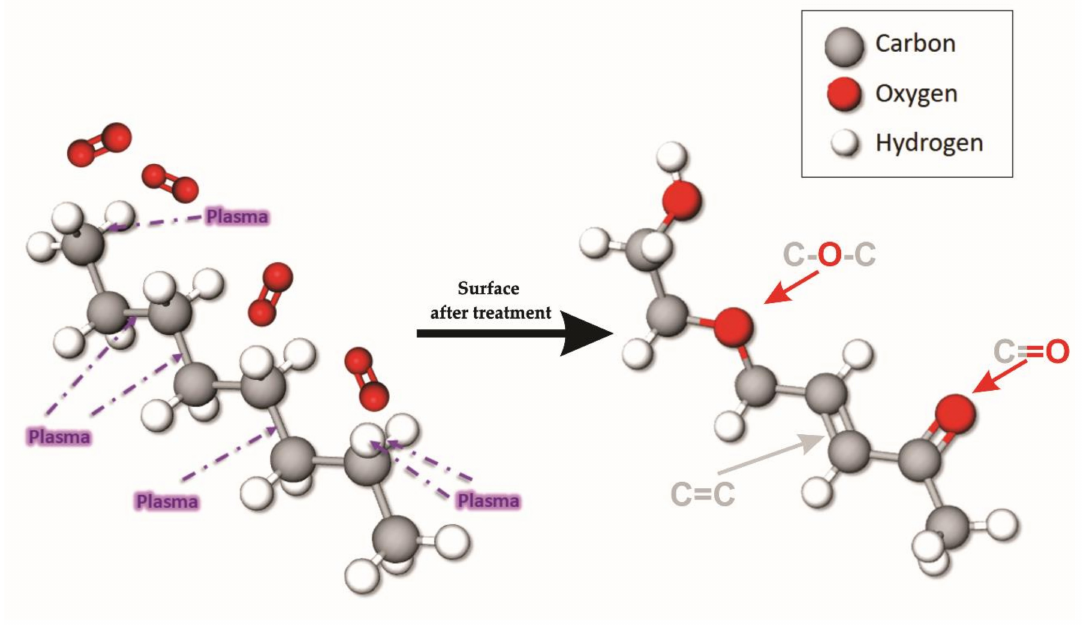
Figure 9. Chemical bonds altered during plasma